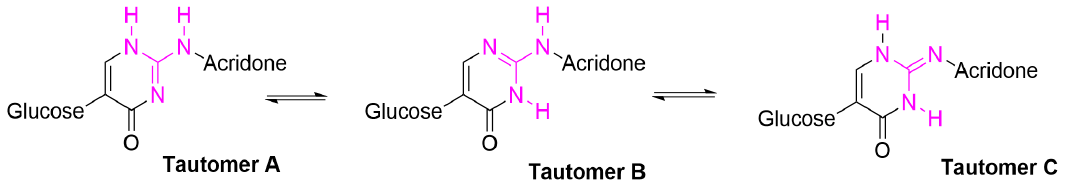
Figure 3. Possible tautomeric forms of Ψ -GLAC (A, B and C) that may affect the dihedral angle between the two chromophores.